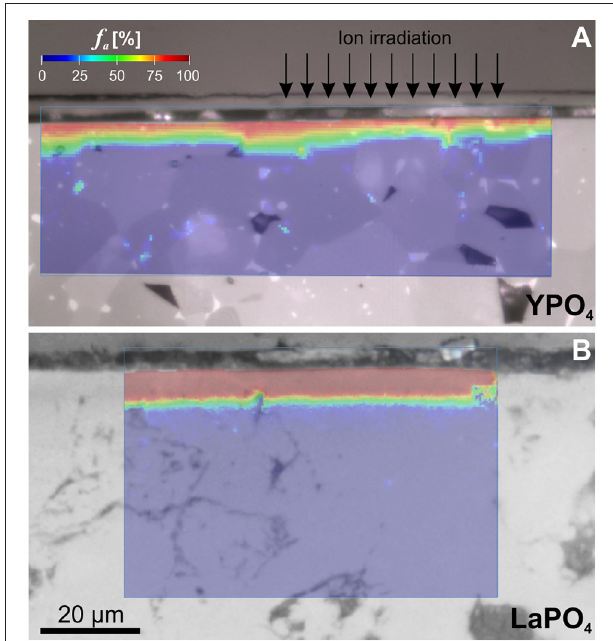
FIGURE 7 | Optical micrograph images (reflection) of cross-sectioned orthophosphates ceramics superimposed by PL hyperspectral maps with the amorphous fraction f a given color-coded (determined as illustrated in Figures 4 , 5 ). (A) YPO 4 ceramic d4 irradiated with a total fluence of 4.85 × 10 13 ions/cm 2 . Note, that the dimension of the irradiated surface layer is not homogeneous across various grains. The irradiation depths vary notably with crystal orientation relative to surface-directed ion-irradiation (indicated by arrows). (B) LaPO 4 ceramic e1 irradiated with a total fluence of 1.5 × 10 13 ions/cm 2 . The entire irradiated 5 µ m thick surface layer was found to be almost completely amorphized at the lowest irradiation fluence